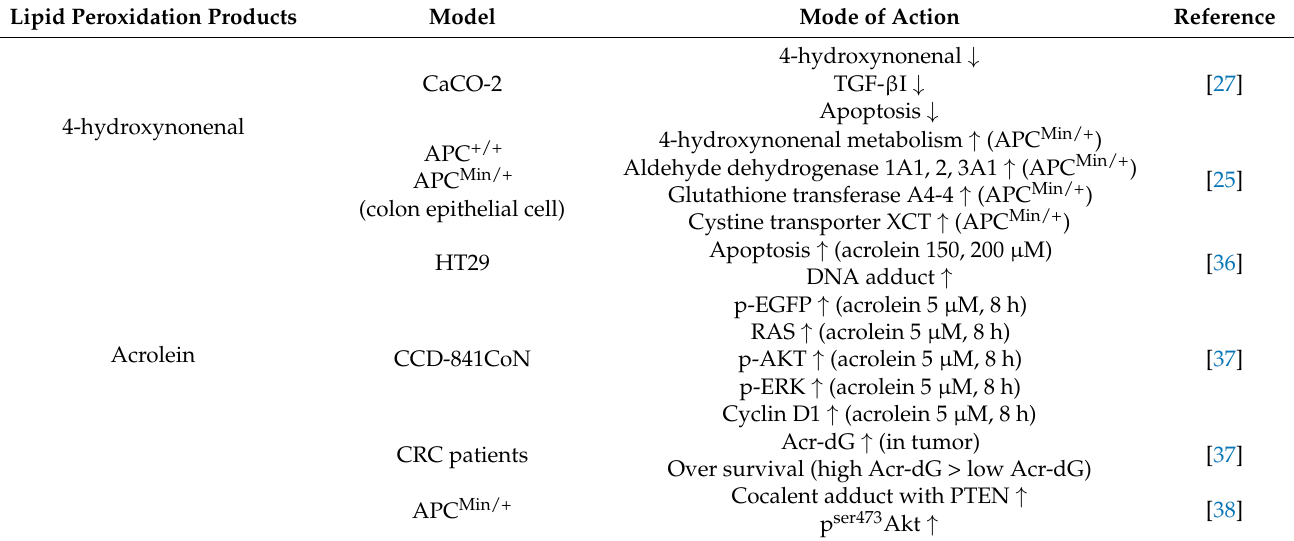
TGF- β I; transforming growth factor, APC; adenomatous polyposis coli, Min; multiple intestinal neoplasia, p-EGFR; phospho-epithelial growth factor receptor, p-AKT; phospho-protein kinase B, p-ERK; phospho-extracellular-signal-regulated kinase, Acr-dG; acrolein-induced DNA damages, PTEN; phosphatase and tensin